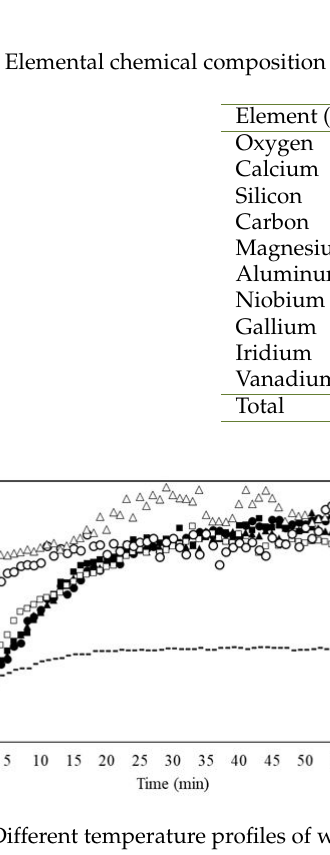
tar had a thermal conductivity of 0.476 W/m · K while